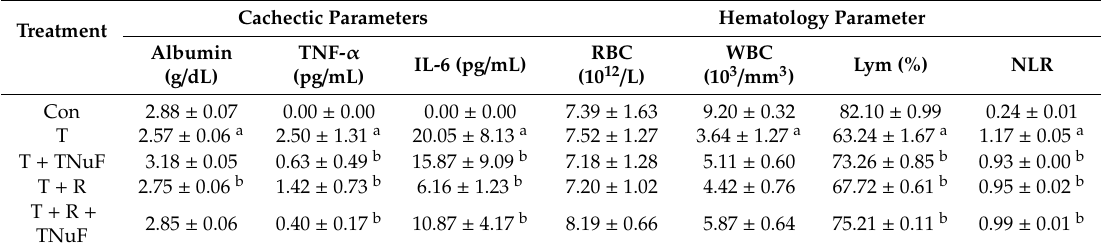
Table 2. E ff ects of TNuF and irradiation on cachectic and hematological parameters in the LLC xenografted mouse